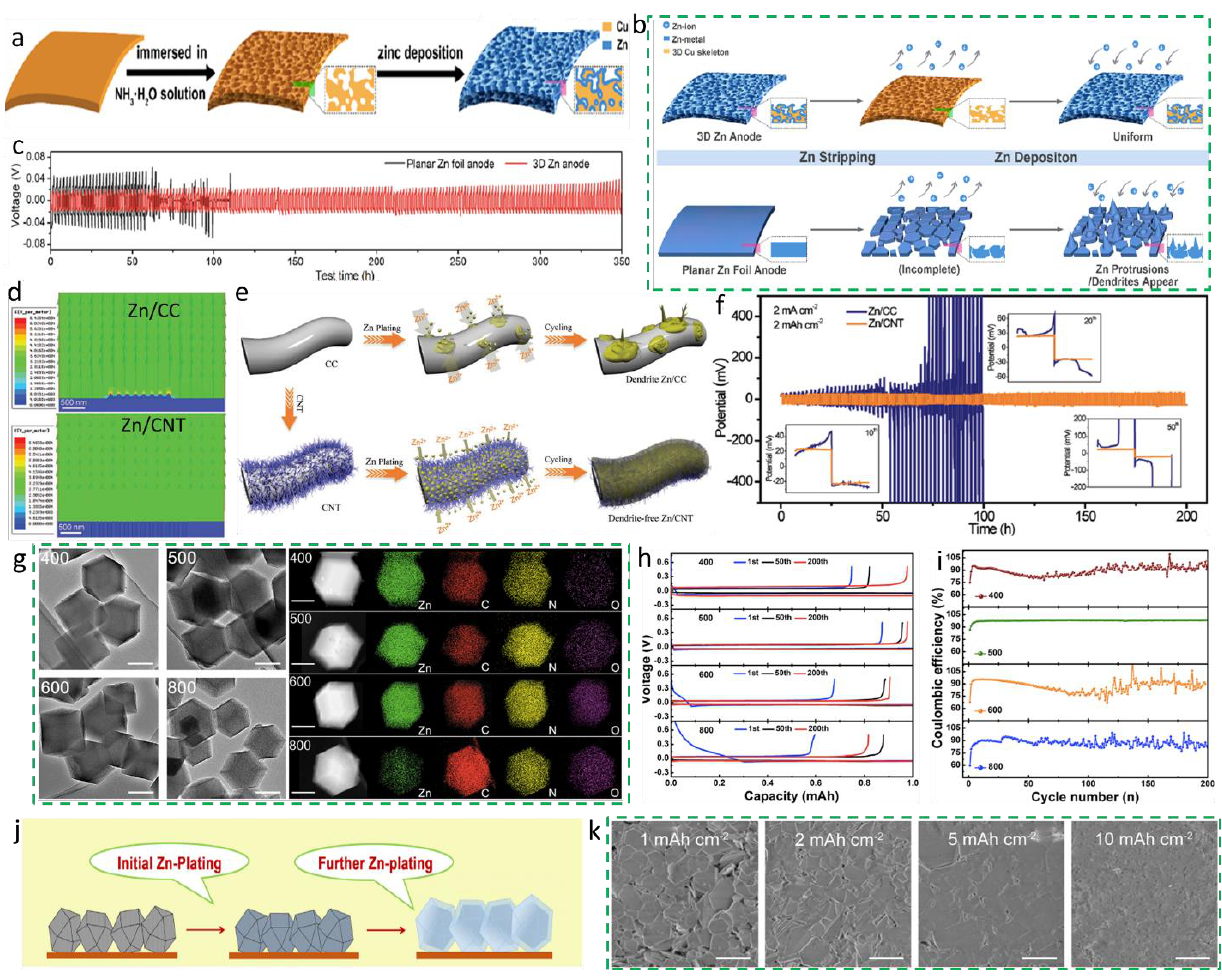
Figure 10. ( a ) Schematic illustration of the procedures to prepare 3DZn@Cu anode, ( b ) schematic diagrams of Zn deposition/stripping processes on 3DZn@Cu and planar Zn foil anode, and ( c ) cycling performance at a constant current of 0.5 mA cm − 2 of 3DZn@Cu and planar Zn foil anodes. (Reproduced with permission. [40] Copyright 2019, American Chemical Society). ( d ) Simulation of electric field distribution on Zn/CC and Zn/CNT, ( e ) schematic illustration of Zn deposition on the CC and CNT electrodes, and ( f ) Electrochemical performance of Zn/CC and Zn/CNT at the current density of 2 mA cm − 2 and areal capacity of 2 mAh cm − 2 . (Reproduced with permission. [118] Copyright 2019, John Wiley & Son). ( g ) TEM images and elemental mapping of the ZIF-8 samples prepared at 400, 500, 600, and 800 °C, ( h ) the polarization of the plating and stripping for the different electrodes at 2 mA cm − 2 and 1 mAh cm − 2 , ( i ) Coulombic efficiency of the plating and stripping for the different electrodes at 2 mA cm − 2 and 1 mAh cm − 2 , ( j ) schematic illustration of Zn plating, and ( k ) SEM images of Zn plating at a current density of 1 mA cm − 2 with different capacities. (Reproduced with permission. [120] Copyright 2019, Elsevier).